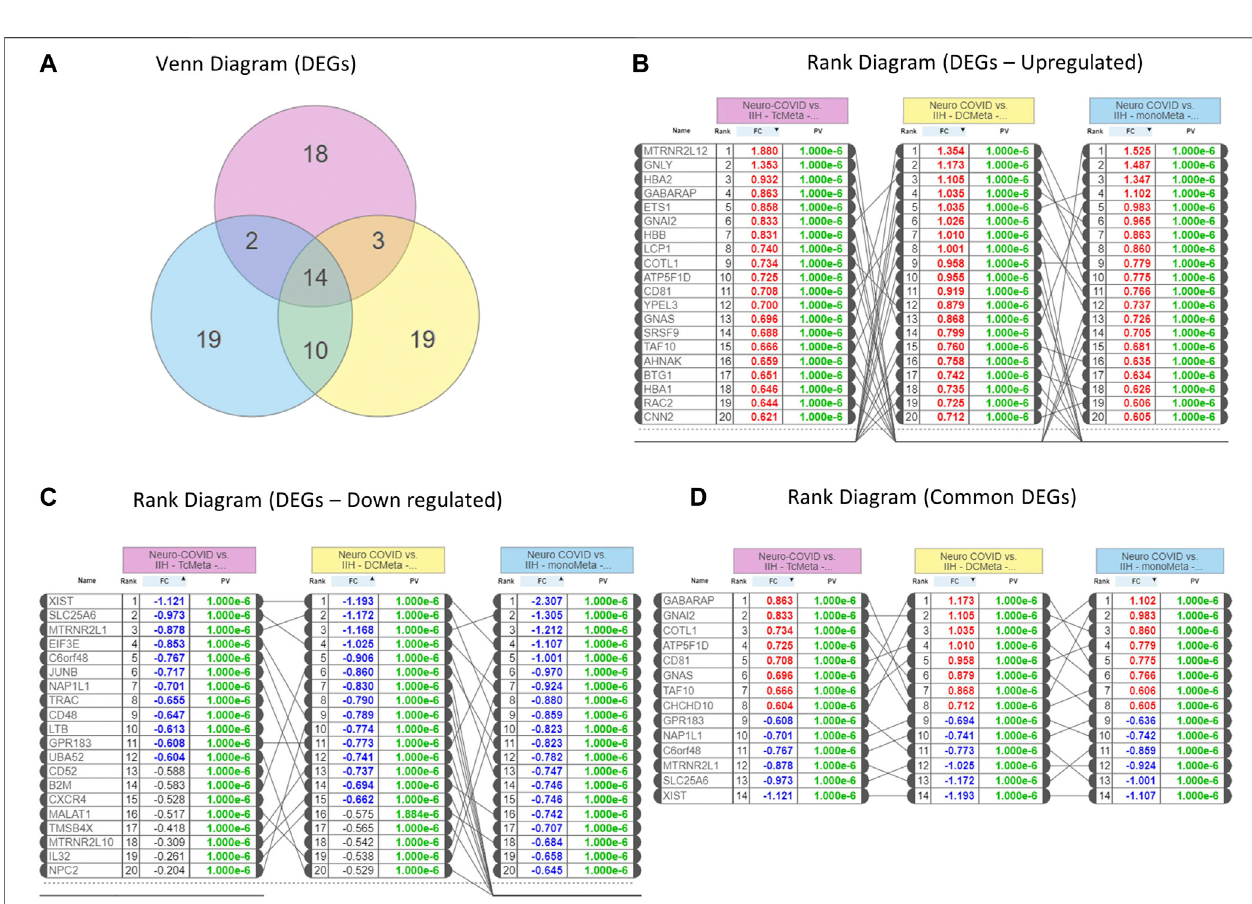
FIGURE 2 | Differentially expressed genes (DEGs) in Neuro-COVID vs. IIH comparison based on iPathwayGuide analysis. (A) Venn diagram shows the DEGs between TcMeta, DCMeta, and monoMeta. (B) The rank diagram shows the upregulated DEGs in TcMeta, DCMeta, and monoMeta. (C) The rank diagram shows the downregulated DEGs in TcMeta, DCMeta, and monoMeta. (D) The rank diagram shows the common DEGs between TcMeta, DCMeta, and monoMeta.